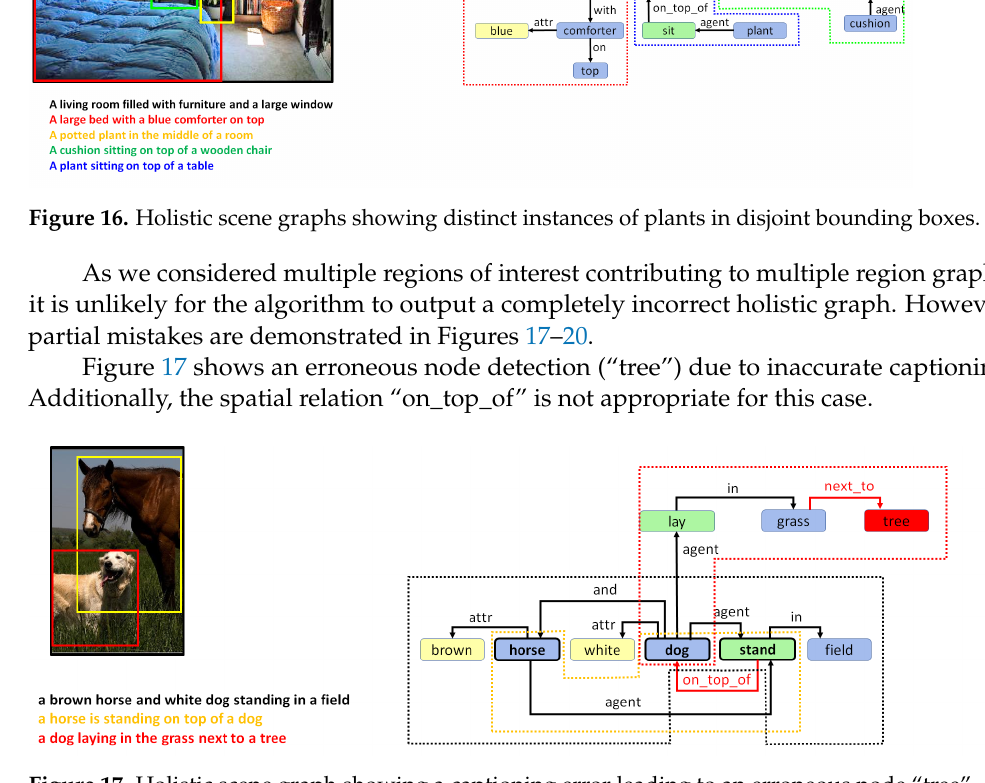
Figure 17. Holistic scene graph showing a captioning error leading to an erroneous node “tree”.